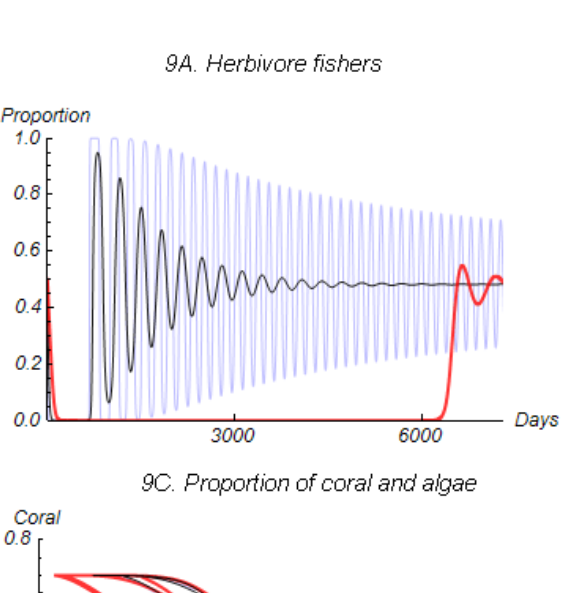
Fig. 9 . Simulation results reflecting changes in the switching speed of fishers, showing time-series plots for fishers (9A) and profit differentials (9D), and parametric plots for fish (9B) and for coral and algae (9C). The dots represent initial